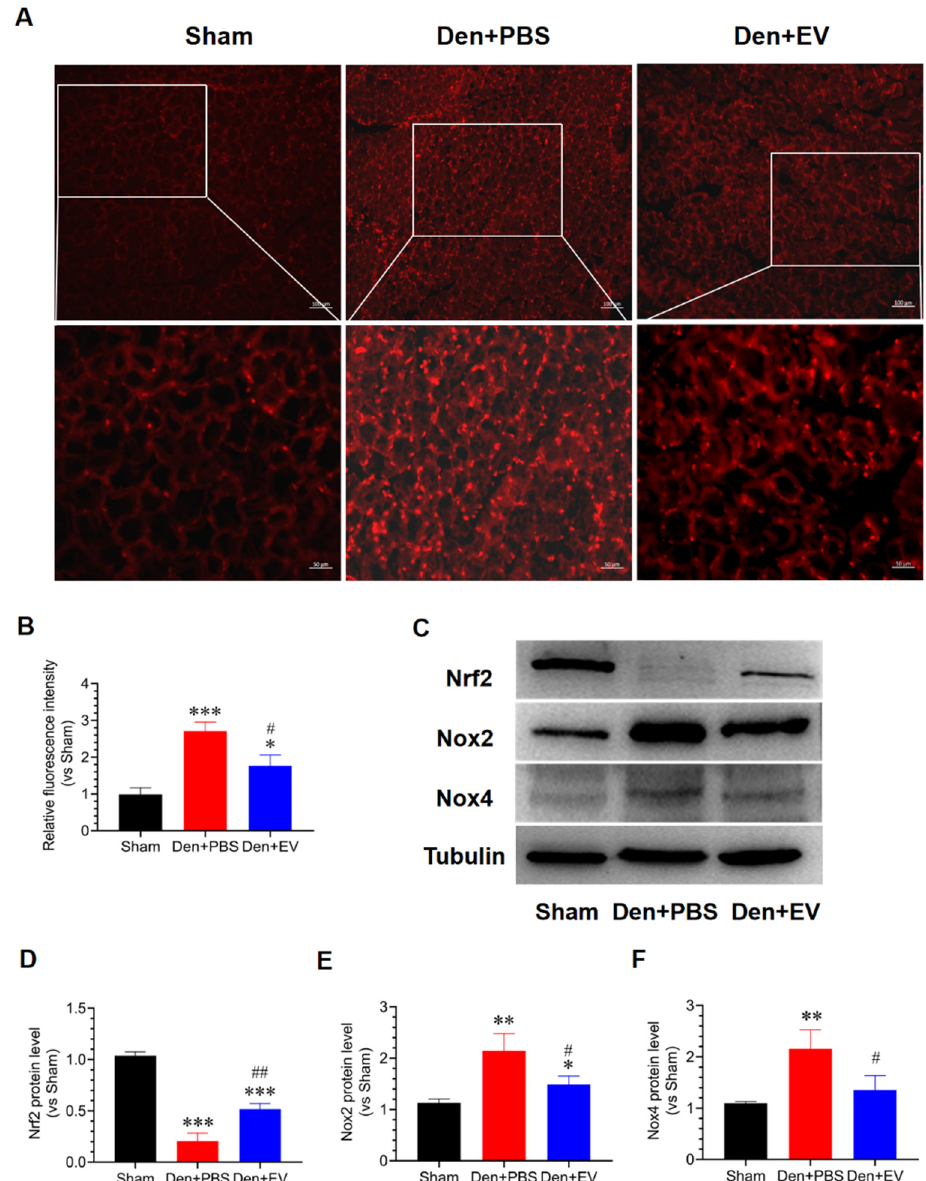
Figure 7. SKP-SC-EVs inhibit oxidative stress of the denervated skeletal muscle. ( A ) DHE (red) staining of the tibialis anterior muscle fiber section. Scale bar = 100 µ m (low magnification); Scale bar = 50 µ m (high magnification). ( B ) Relative quantification of DHE fluorescence intensity; n = 5, * p < 0.05 and *** p < 0.001 vs. Sham group; # p < 0.05 vs. Den + PBS group. ( C ) Representative western blot detection of the levels of Nrf2, Nox2, and Nox4 in the tibialis anterior muscle in different treatment groups. ( D – F ) Histogram of the relative levels of Nrf2, Nox2, and Nox4 proteins. n = 3, * p < 0.05, ** p < 0.01, and *** p < 0.001 vs. Sham group; # p < 0.05 and ## p < 0.01 vs. Den + PBS group. The sham group was injected with PBS; the Den group was injected with PBS containing SKP-SC-EVs (5 × 10 10 particles) (Den + EV group), and; the control PBS group (Den + PBS group) was injected with PBS. The tibialis anterior muscle samples were collected 14 days after treatment. Den, denervation; DHE, dihydroethidium; EVs, extracellular vesicles; SCs, Schwann cells; SKP, skin-derived precursors.